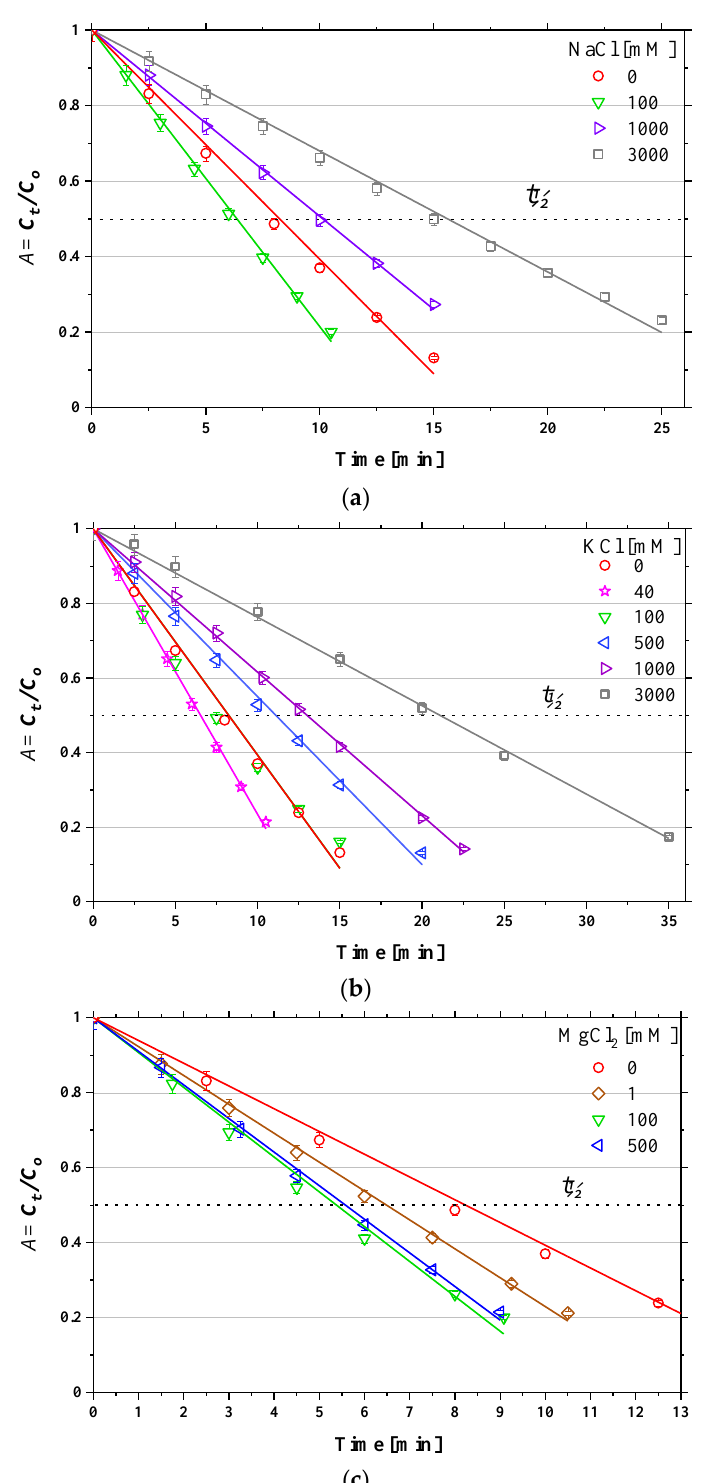
Figure 1. Degradation of caffeine as a function of time, at various NaCl ( a ), KCl ( b ), and MgCl 2 ( c ) concentrations. Plots were evaluated using a pseudo-zero-order kinetic model.